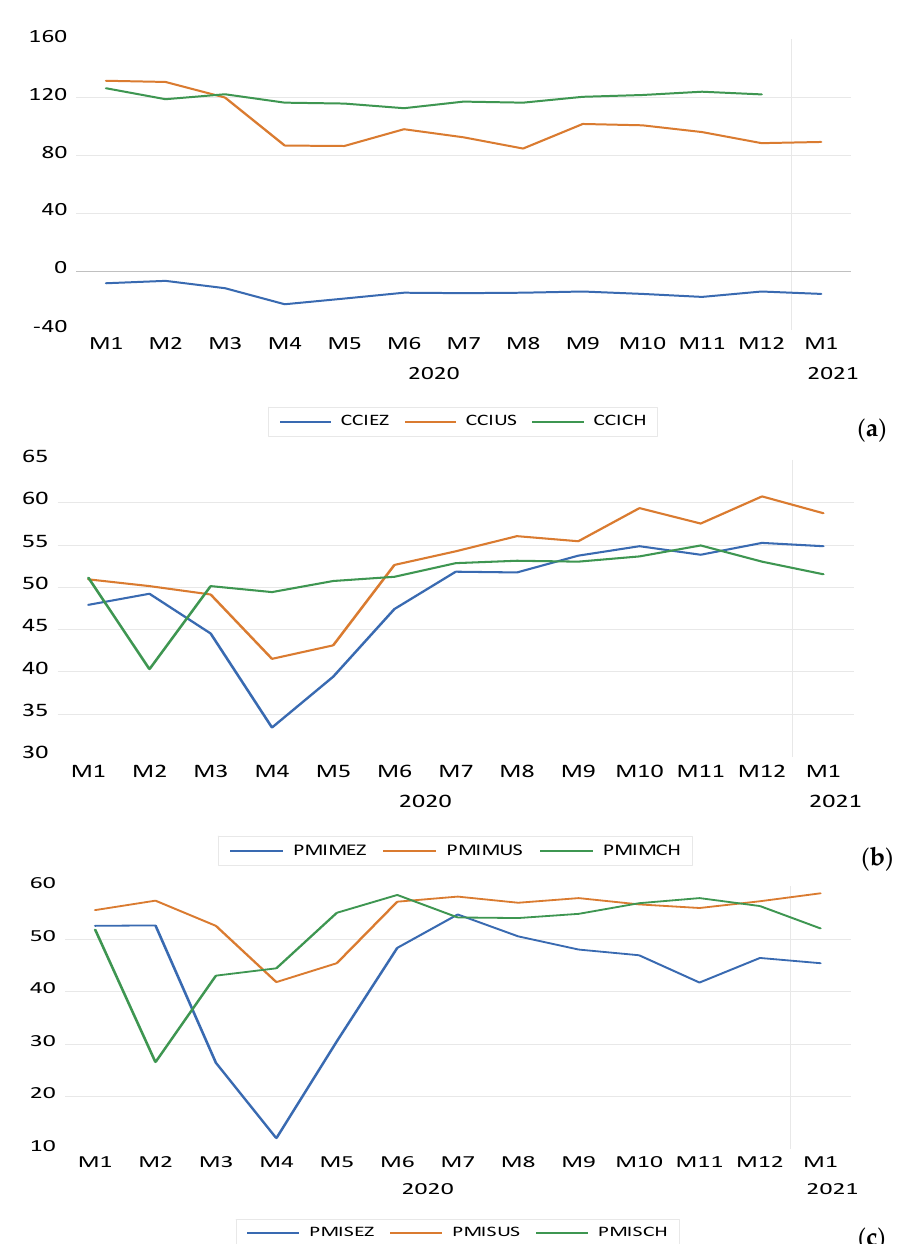
Figure 1. Dynamics of CCI ( a ), and manufacturing ( b ) and services ( c ) PMI, in the Eurozone, the United States, and China (January 2020–January 2021). Source: compiled by the authors based on Thomson Reuters data. Note: M1 = January, M2 = February, M3 = March, M4 = April, M5 = May, M6 = June, M7 = July, M8 = August, M9 = September, M10 = October, M11 = November, M12 = December. For CCIEZt, PMIMEZt, PMISEZt, CCIUSt, PMIMUSt, PMISUSt, CCICHt, PMIMCHt, and PMISCZt, see Table 1.